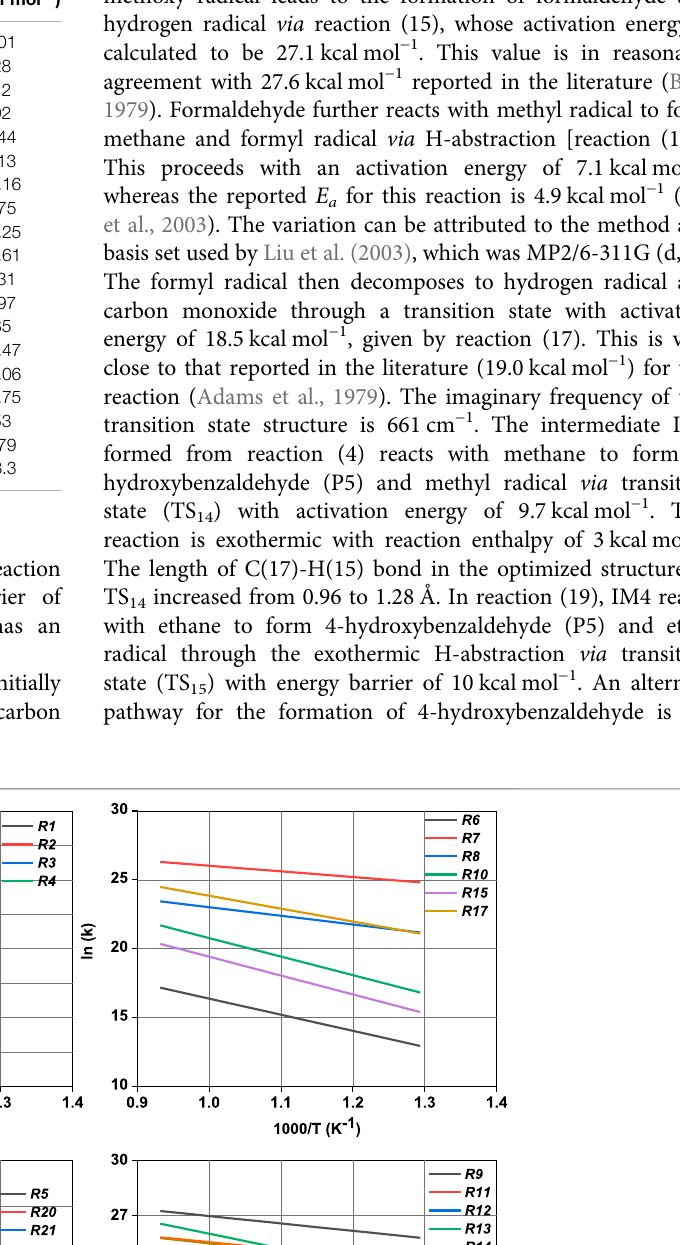
TABLE 4 | Reaction enthalpy, entropy, and Gibbs free energy calculated at 298.15 K and 1 atm using M06-2X/6-31++G (d, p) level of theory. Reaction no.